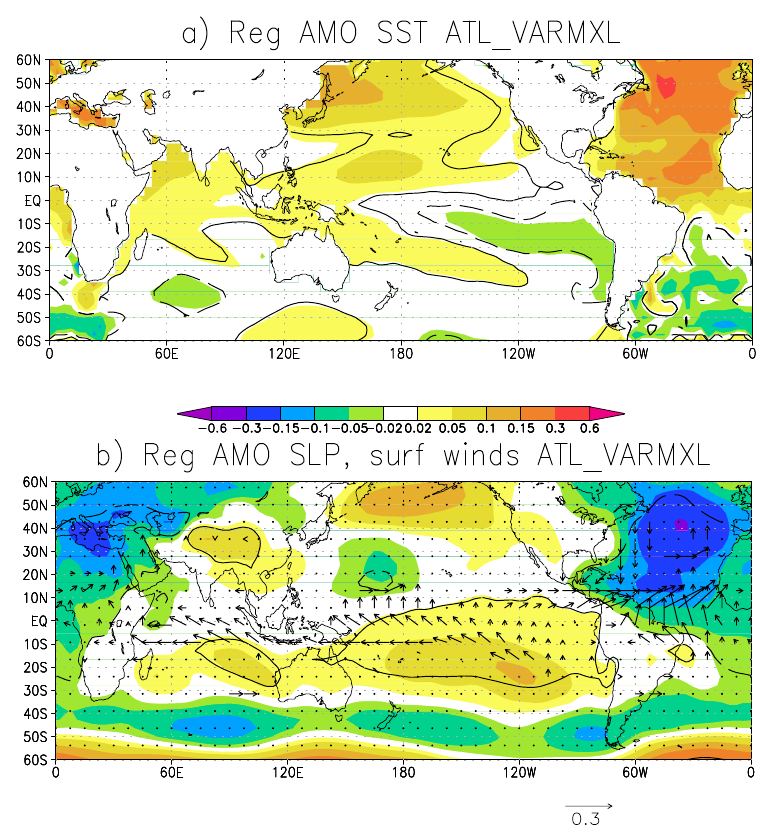
Figure 14. Response of ATL_VARMXL on ( a ) SST and ( b ) SLP and low-level winds to AMO forcing. SST and SLP anomalies that are 95% statistically significant are indicated by contours, and only statistically significant wind vector components are shown. Units are K for SST, hPa for SLP and m/s for